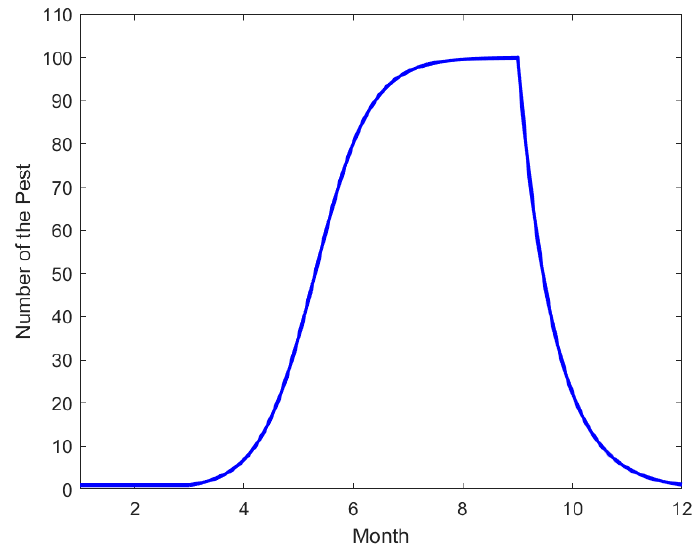
Figure 6. The graph of hornets’ number over time.